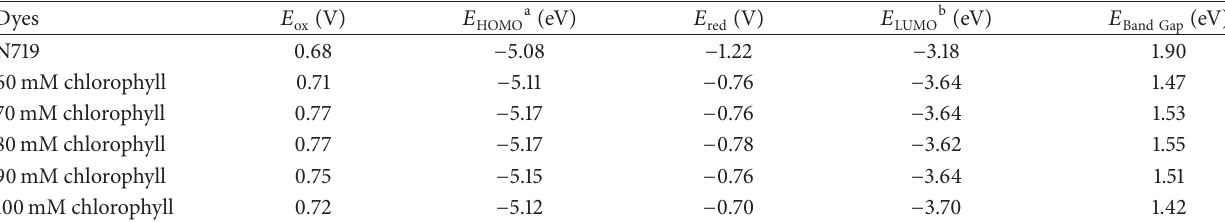
Table 1: Energy levels of N719 and chlorophyll dyes.